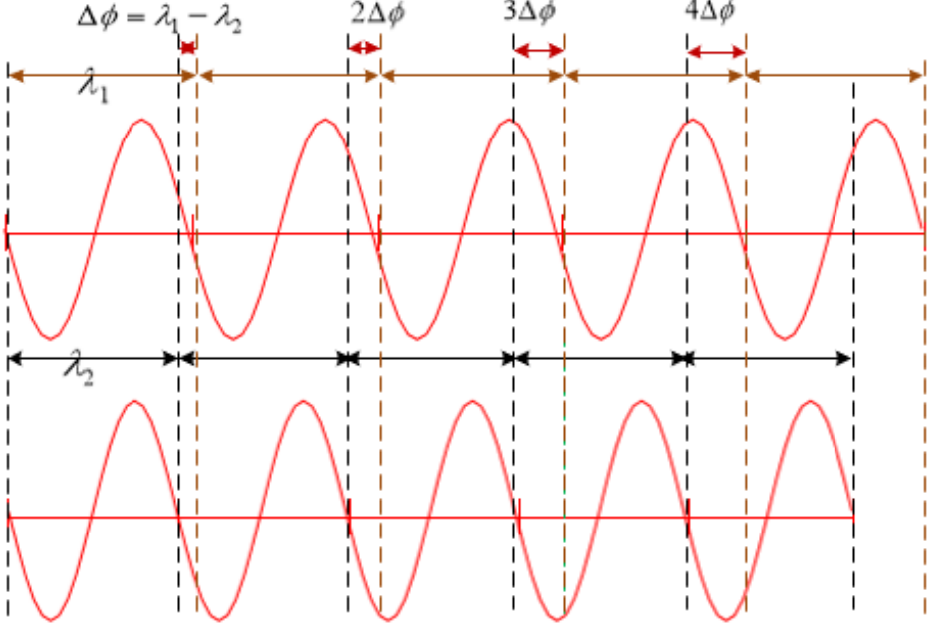
Figure 2. Phase quantization relationship between periodic signals.